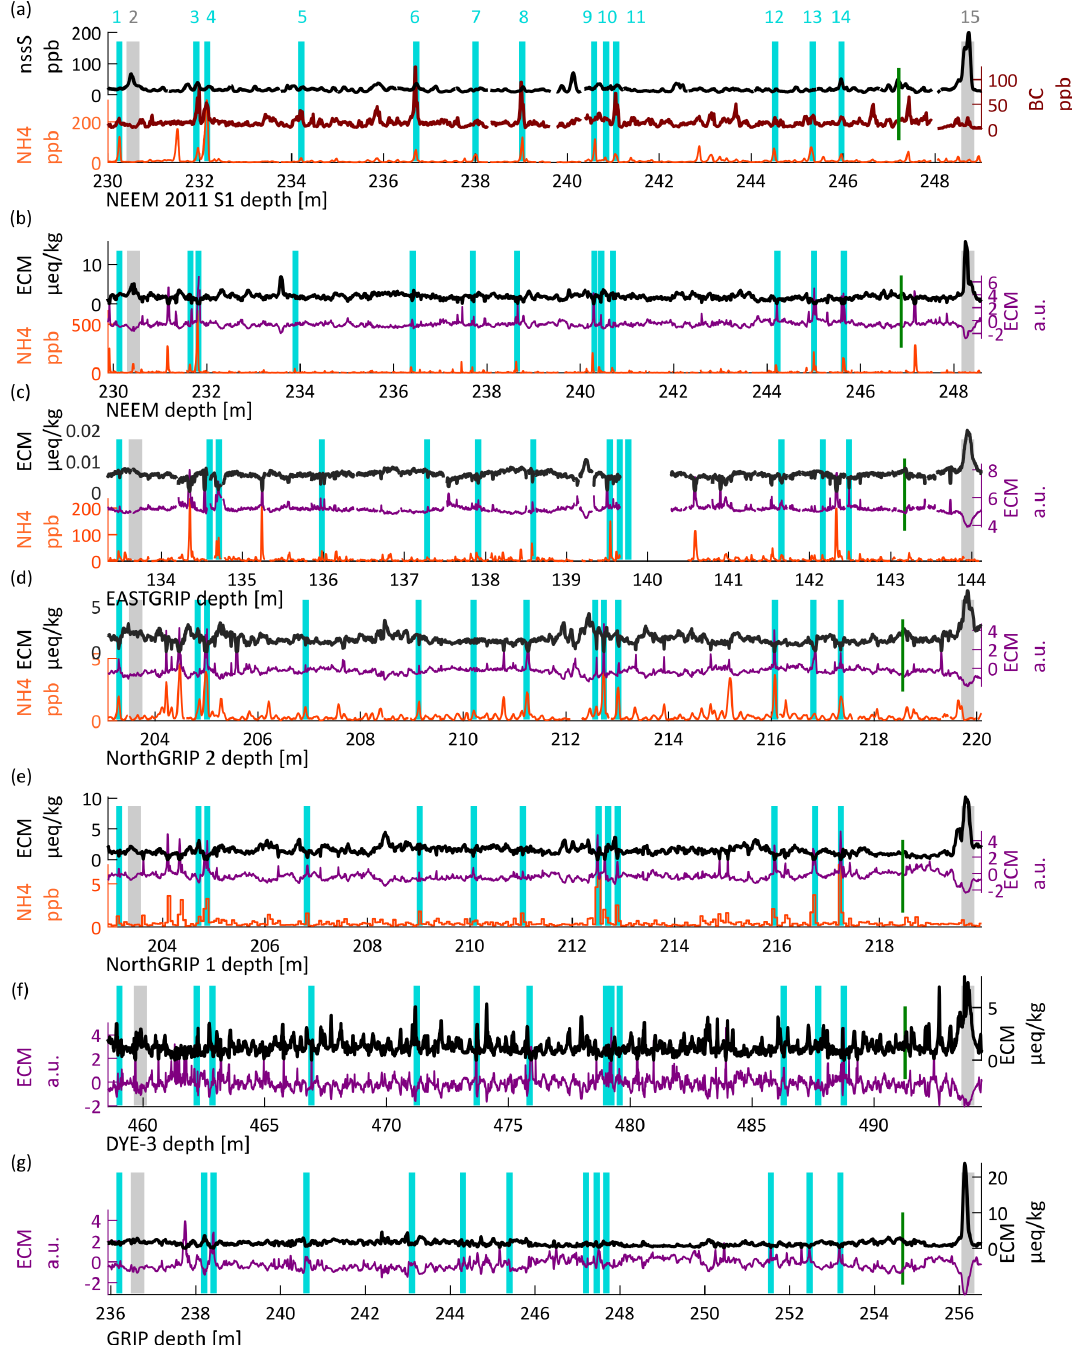
Figure 2. Tie points of GICC21 between two eruptions, which are highlighted by the gray vertical bars nos. 2 and 15 (Eldjá, 939CE). Volcanic proxies are shown in black, and the inverted log-ECM for each ice core is shown in purple. Ammonium (where available) is shown in orange and the turquoise bars highlight the patterns of ammonium that were used as supporting tie points for GICC21. (a) NEEM-2011- S1: the black-carbon peaks (brown) support the choice of this subset of ammonium tie points. (b–e) The co-occurrence of ammonium peaks and peaks in the log-inverted ECM provides another criterion for tie-point selection. (f–g) For DYE-3 and GRIP, lack of ammonium data means that we can only use the log-inverted ECM to provide indication for the tie points, of which nos. 3, 4, 5, 6, 11, 12, and 14 are best recognizable. The green bar between 14 and 15 highlights the very subtle ECM peak associated to the Tianchi tephra (Sun et al., 2014).